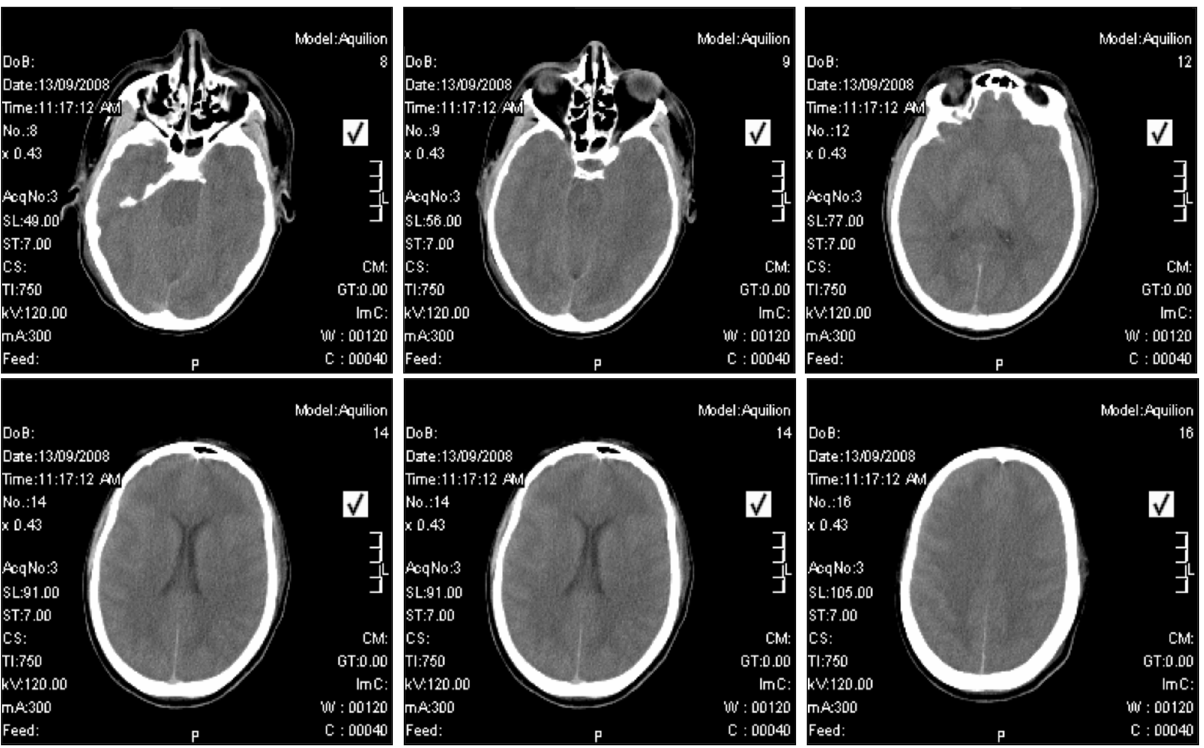
Figure 2. CT scan of the brain of Patient 5 showing cerebral edema on illness day 12.